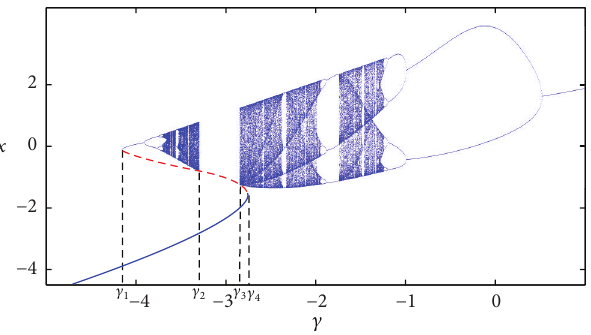
Figure 1: Attractors of the deterministic Rulkov